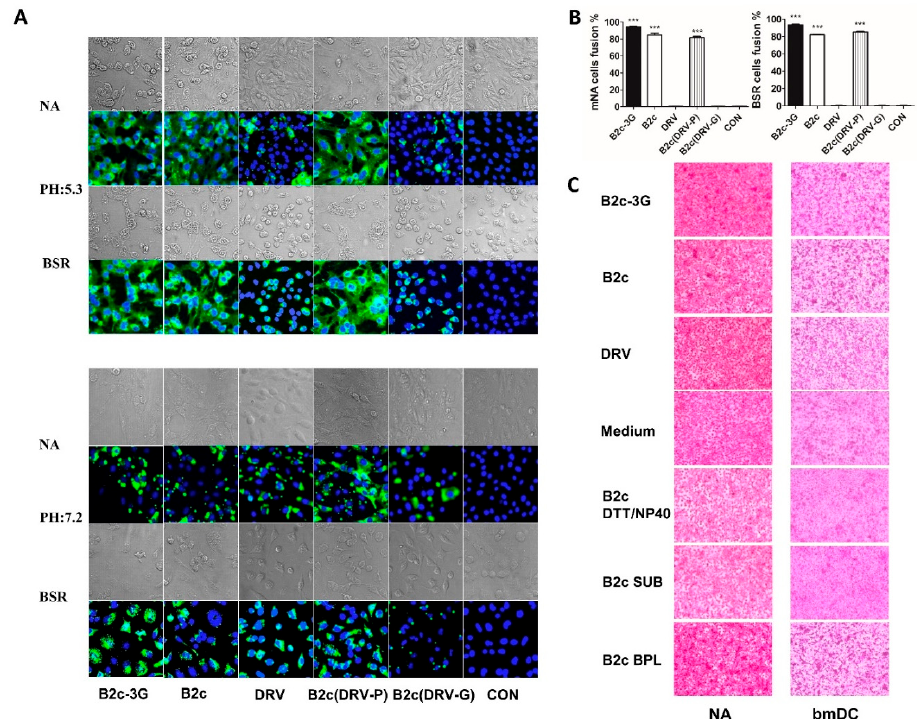
Figure 4. RABV-G-mediated cell-to-cell fusion. ( A ) BSR and NA cells were infected with the indicated viruses for 48 h followed by microscopic evaluation of cell-to-cell fusion at pH 7.2 or pH 5.3. ( B ) Cell fusion index was determined by calculating the ratio of the number of nuclei of multinucleated cells to the number of total nuclei in the photographs taken of randomly selected fields, in which 300 nuclei or more were counted. ( C ) NA and bmDC cells were treated with the indicated viruses for 4 h before microscopic evaluation of cell-to-cell fusion at pH